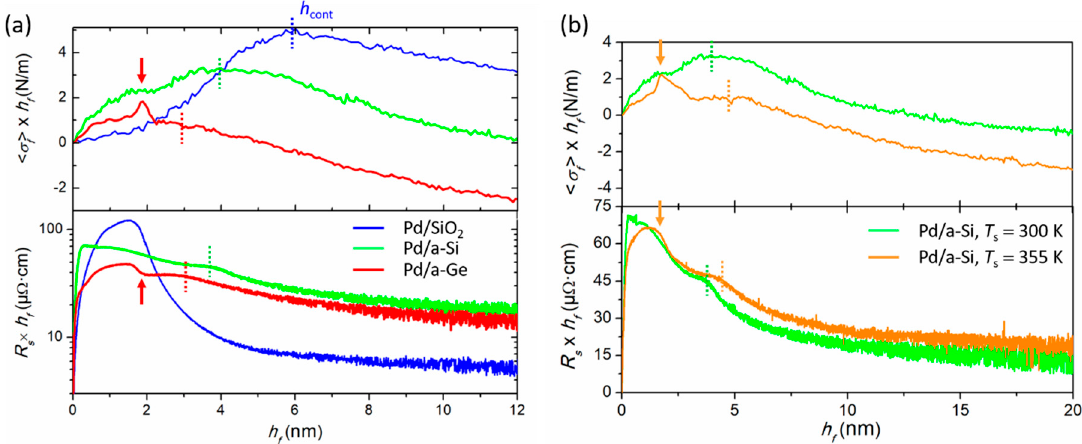
(cid:68) (cid:69) σ × h × h Figure 12. Real-time evolution of Figure 12. Real-time evolution of 〈𝜎 (cid:3033) 〉 × ℎ (cid:3033) and 𝑅 (cid:3046) × ℎ (cid:3033) curves vs. ℎ (cid:3033) during sputter-deposition of f f and R s f curves vs. h f during sputter-deposition of Pd films on ( a ) SiO 2 , a-Si and a-Ge at T = 300 K and ( b ) a-Si at T = 300 and 355 K. The curves exhibit distinct Pd films on ( a ) SiO 2 , a-Si and a-Ge at T = 300 K and ( b ) a-Si at T = 300 and 355 K. The curves exhibit features at critical transition thickness, marked by arrows and vertical dashed lines (for interpretation, distinct features at critical transition thickness, marked by arrows and vertical dashed lines (for see interpretation, see text).